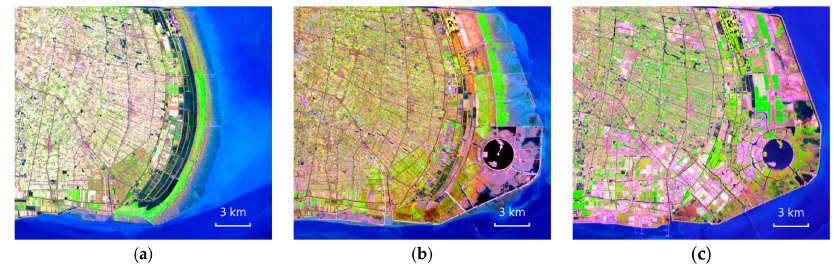
Figure 2. Landsat TM/ETM+ images over LNC in ( a ) 3 November 1999 and, ( b ) 16 December 2003, and ( c ) 6 May